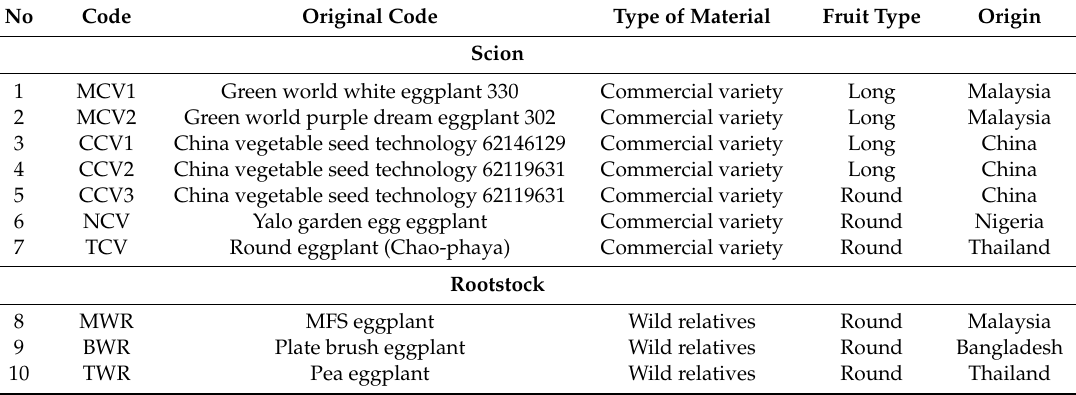
Table 5. Accessions ( Solanum melongena ) and species used for this